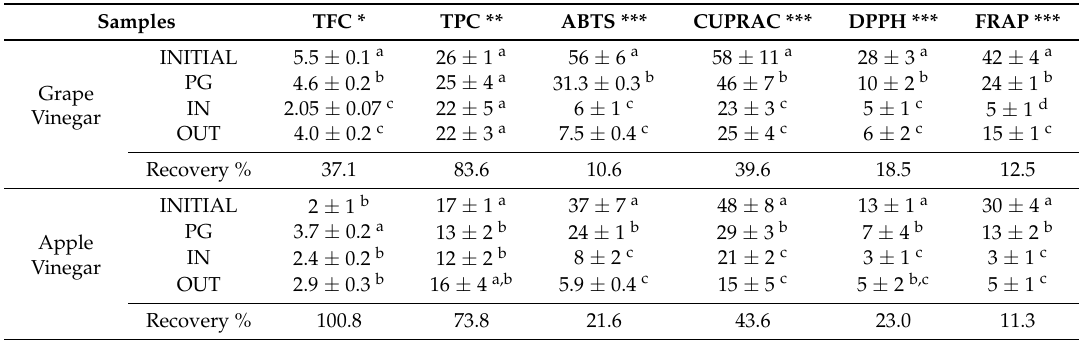
Table 4. Total flavonoid, phenolic content, and total antioxidant capacity of in vitro digested grape and apple vinegars.